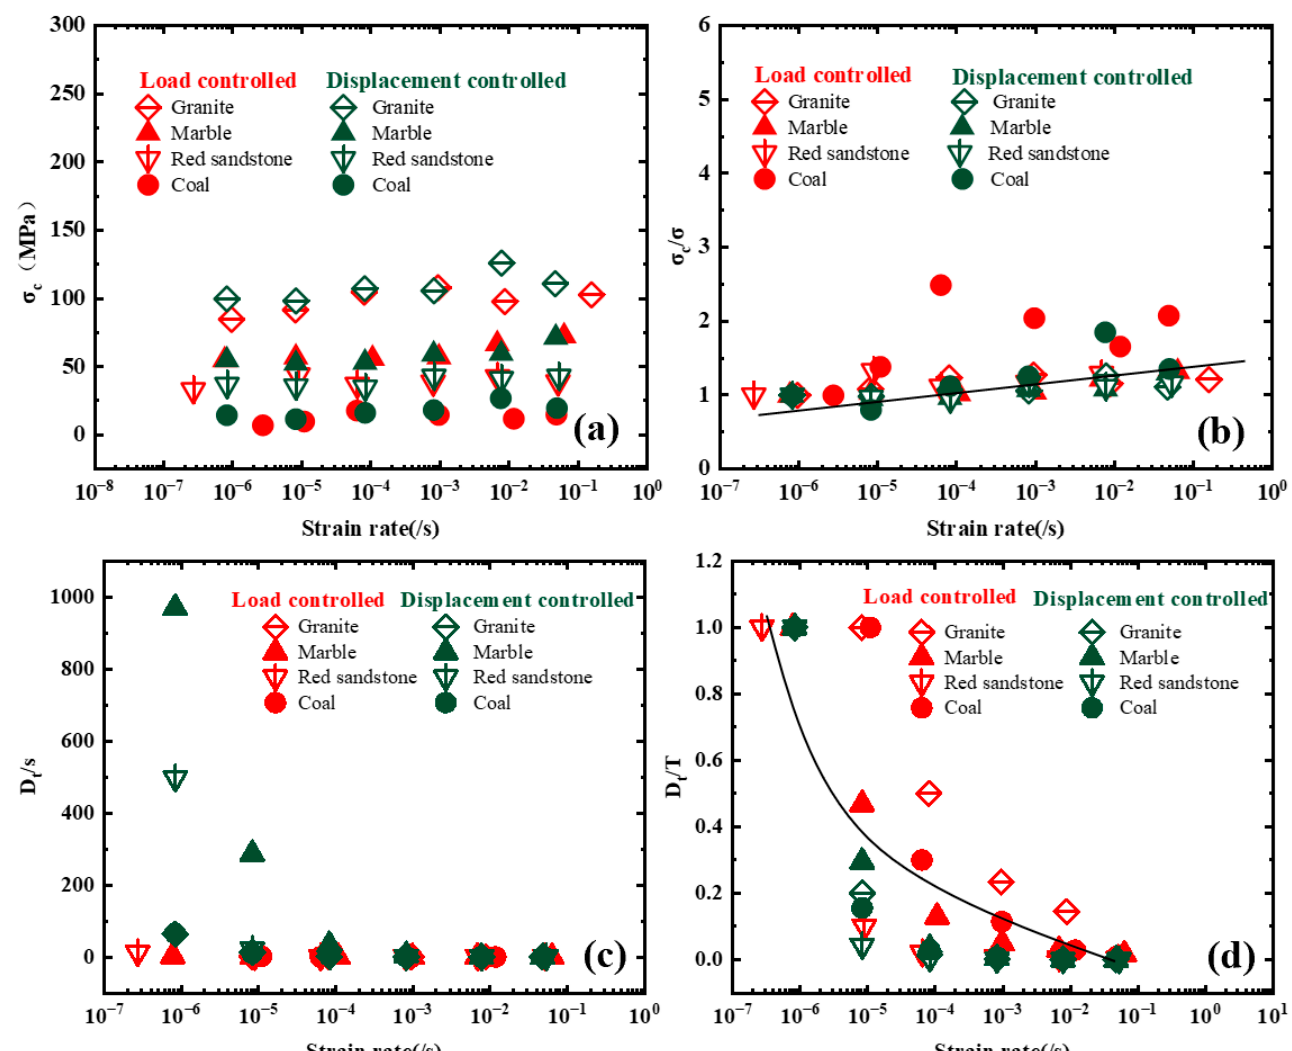
Figure 13. Relationships between ( a ) uniaxial compressive strength vs. time, ( b ) normalization uniaxial compressive strength vs. time, ( c ) Dt vs. time, and ( d ) normalization Dt vs. time.